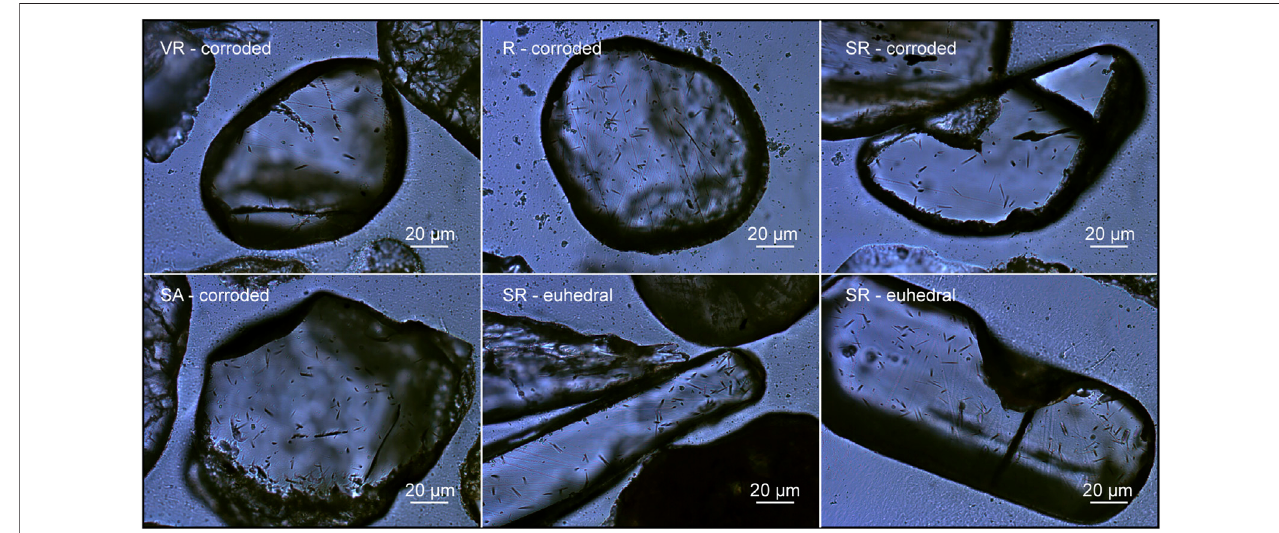
FIGURE 2 | Roundness and crystal textures characteristics of apatite particles.